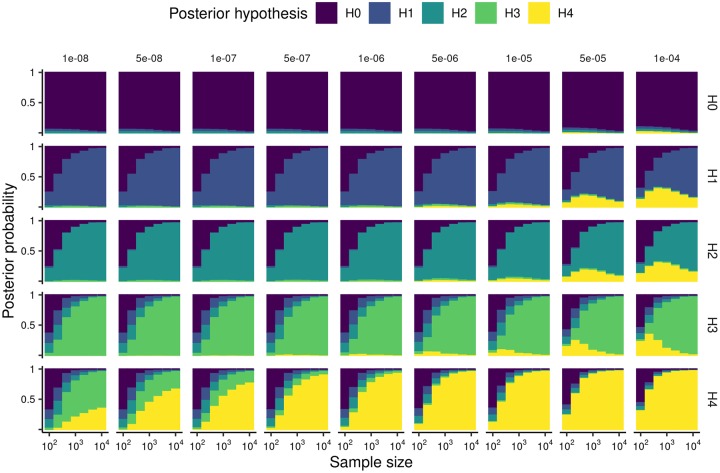
Distribution of expected posterior probabilities
across a wide range of simulated data.In all analyses we fixed p2 = p1 = 10−4 and varied p12. Coloured bar heights represent the average posterior probability for each hypothesis over the set of simulations for a given simulated hypothesis and sample size.